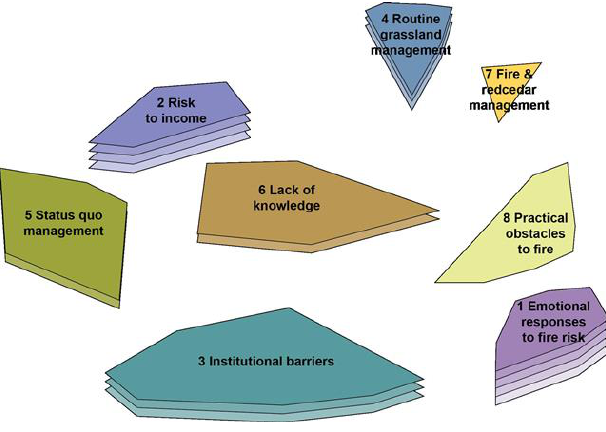
Fig. 2 . Concept map clusters of landowners' reasons for not implementing grassland conservation practices that improve conditions for